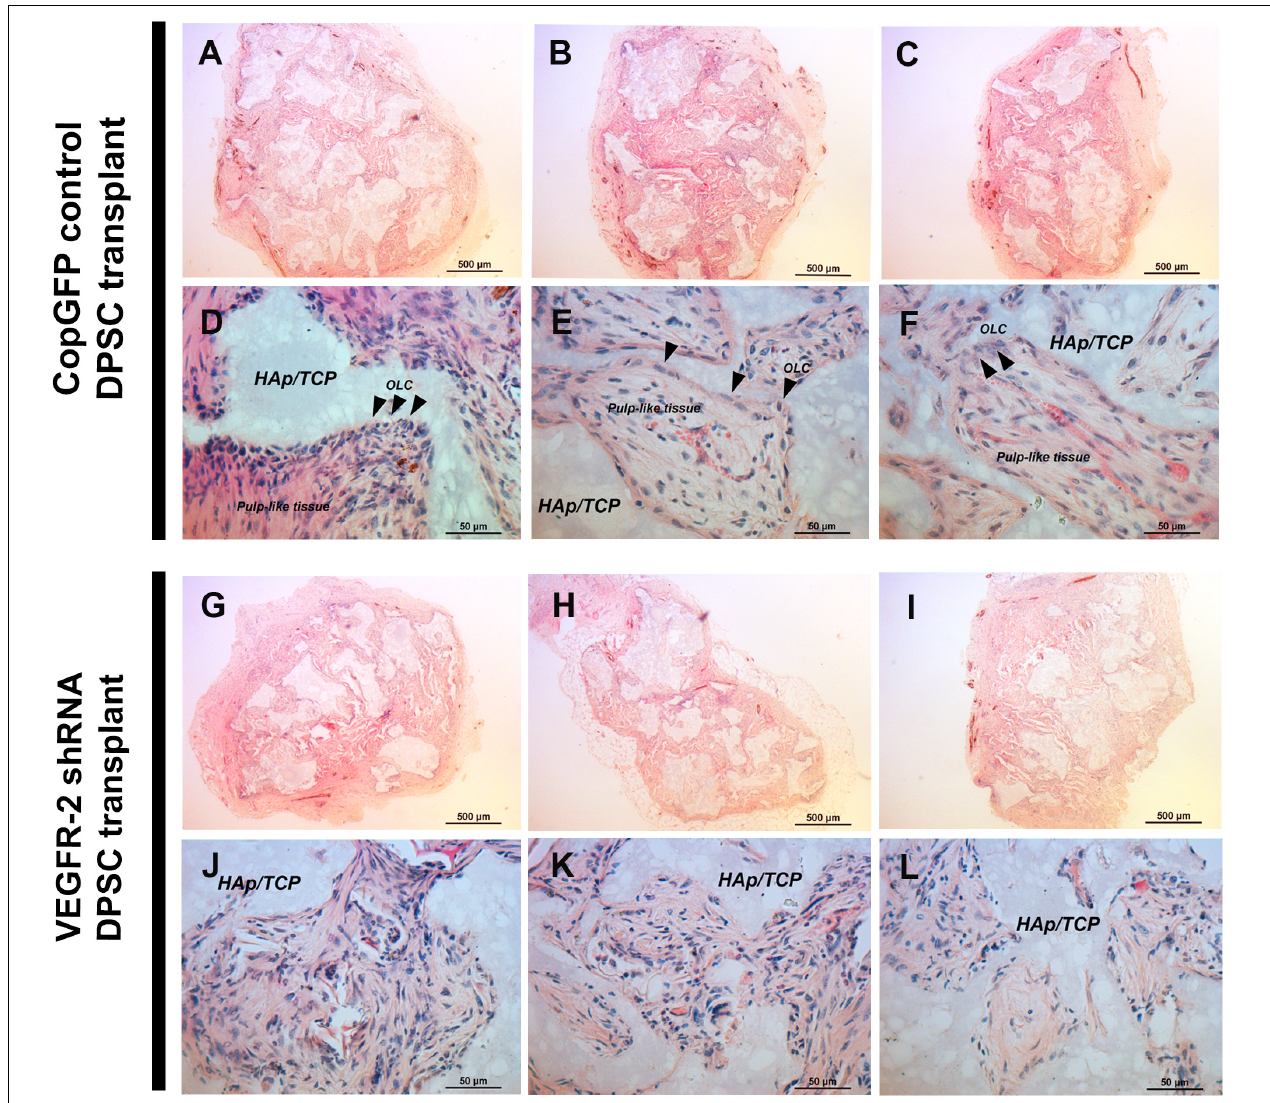
FIGURE 6 | In vivo transplantation of CopGFP control and VEGFR-2 shRNA DPSCs by H&E staining. 1 × 10 6 cells of CopGFP control and VEGFR-2 shRNA DPSCs were separately transplanted into 1-month-old male Rag1 null mice by dorsal subcutaneous transplantation with hydroxyapatite tricalciumphosphate (HAp/TCP) ( n = 5 mice per cell type). Transplanted tissues were harvested after 5 weeks, then proceeded and stained for analysis. H&E staining was performed to demonstrate the morphology of CopGFP DPSC transplants [ (A–C) ; low magnification of representative tissues] and VEGFR-2 shRNA DPSC transplants [ (G–I) ; low magnification of representative tissues]. Scale bars indicate 500 µ m. CopGFP DPSC transplants exhibited elongated and polarized odontoblast-like cells (OLC) (arrowheads) and more organized loose connective tissue with abundant blood vessels mimicking pulp-like structures (D–F) while VEGFR-2 shRNA DPSC transplants showed